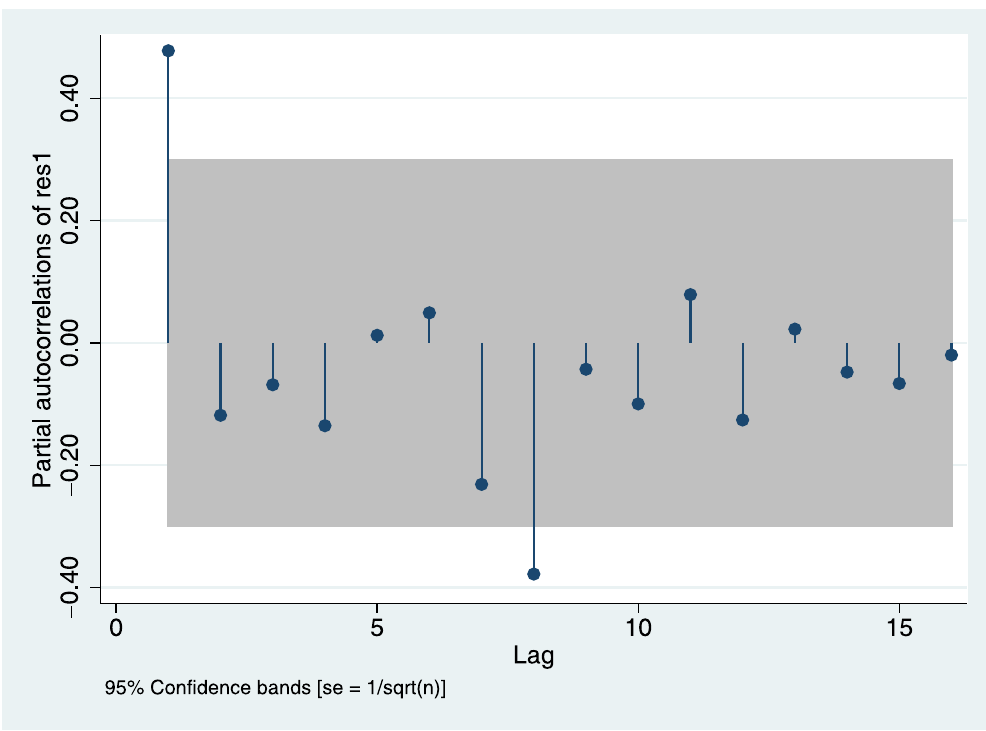
Fig 11. Partial Autocorrelation of Residuals. From OLS of # of habilitations in year t, controlling for # of new students in t-20 and the time trend.